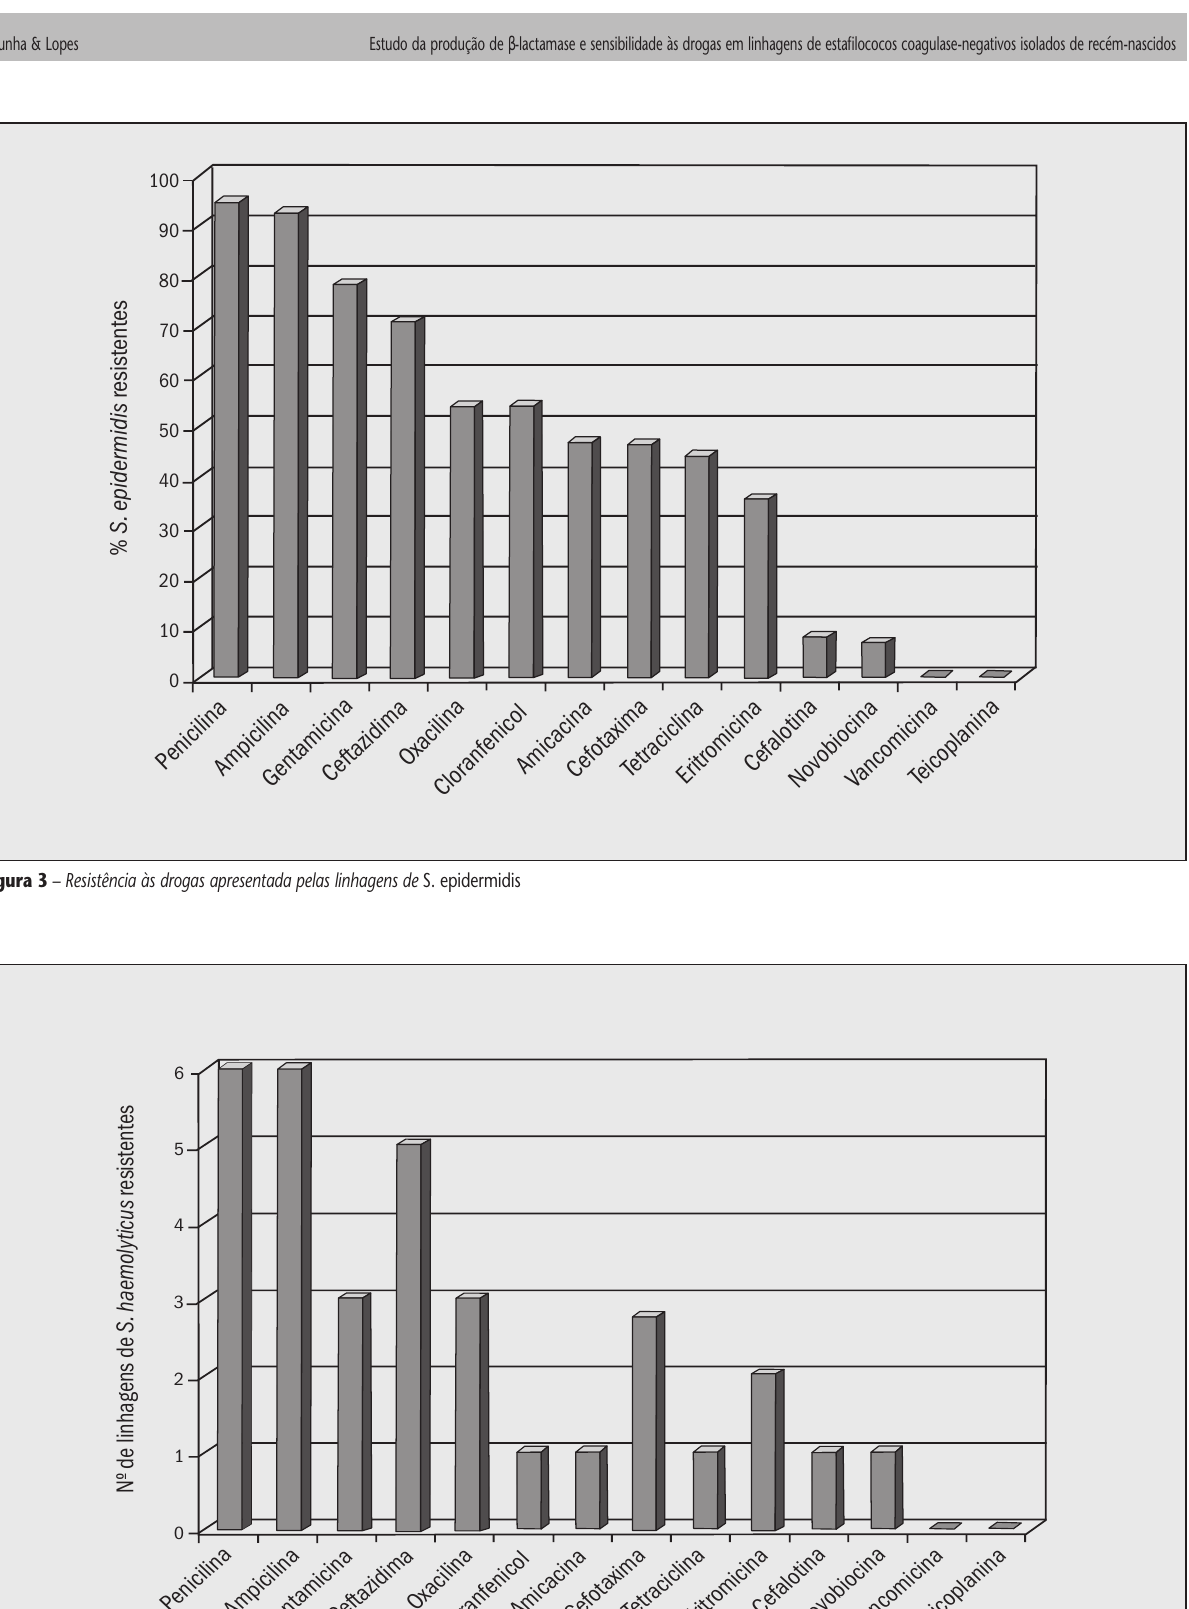
Figura 4 – Resistência às drogas apresentada pelas linhagens de S. haemolyticus